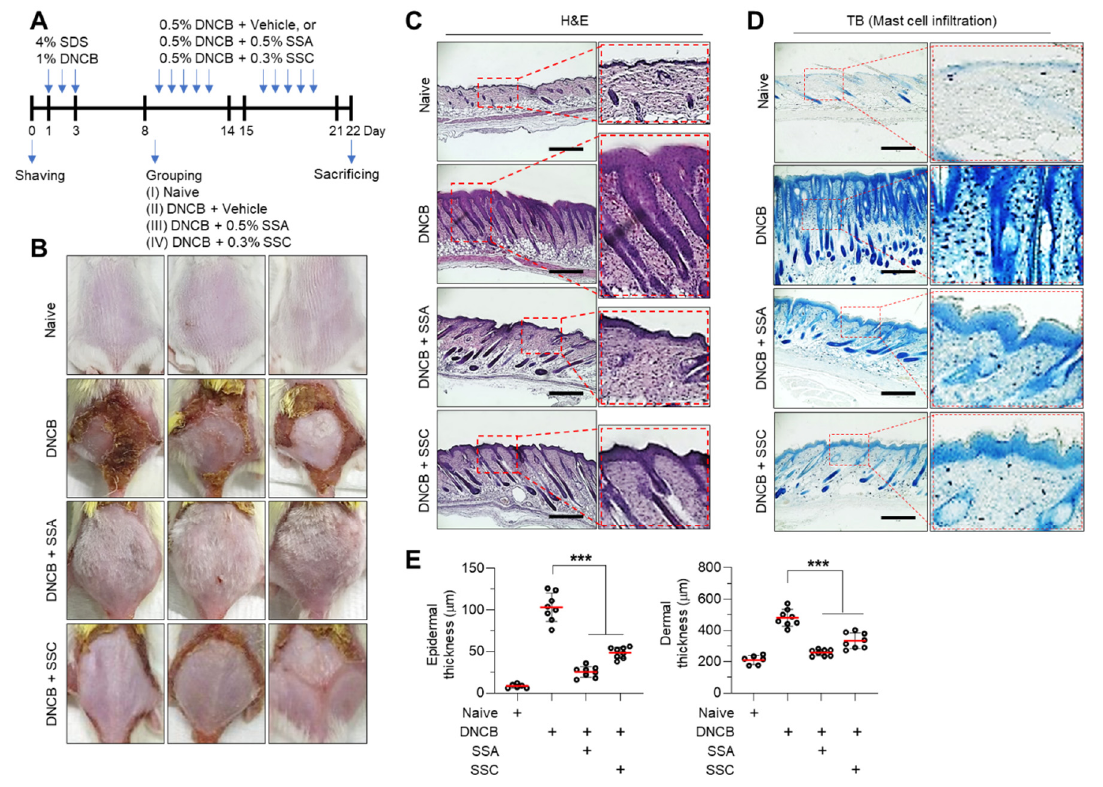
Figure 8. Effect of topical application of SSA and SSC on the amelioration of dinitrochlorobenzene (DNCB)-induced AD-like skin lesions in BALB/c mice. ( A ) Experimental design for the induction of AD-like skin lesions. ( B ) Representative images of the back skin of BALB/c mice, challenged with DNCB in the presence or absence of 0.5% SSA or 0.3% SSC, were acquired on day 22. ( C , D ) Paraffin-embedded skin tissues were prepared and stained with hematoxylin and eosin ( C ) and toluidine blue ( D ) . Scale bars, 200 µm. ( E ) Epidermal and dermal thicknesses were measured using ImageJ software. Data are presented as means ± SD (Vehicle group, n = 6; Treated group, n = 8). *** p < 0.001 by Sidak’s multiple comparisons test.